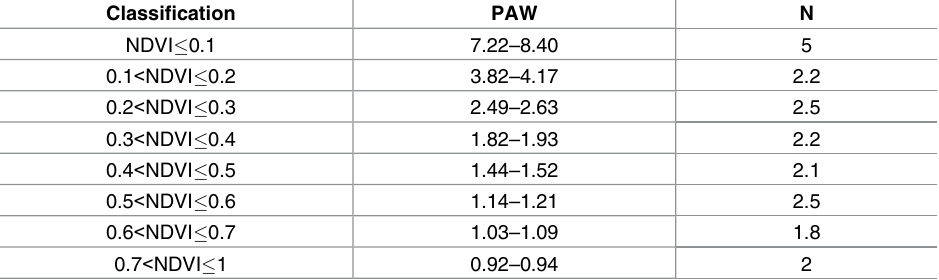
Table 6. Parameters (PAE and N) of the revised Bagrov modeling of ETa values in rocky desertifica- tion